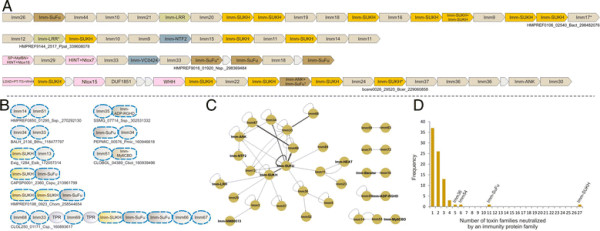
(A) Representative examples of poly-immunity gene loci. (B) Representative examples of poly-immunity proteins. (C) Domain architecture network of immunity domains in poly-immunity proteins. (D) Frequency of immunity protein families that neutralize a given number of toxin domains.